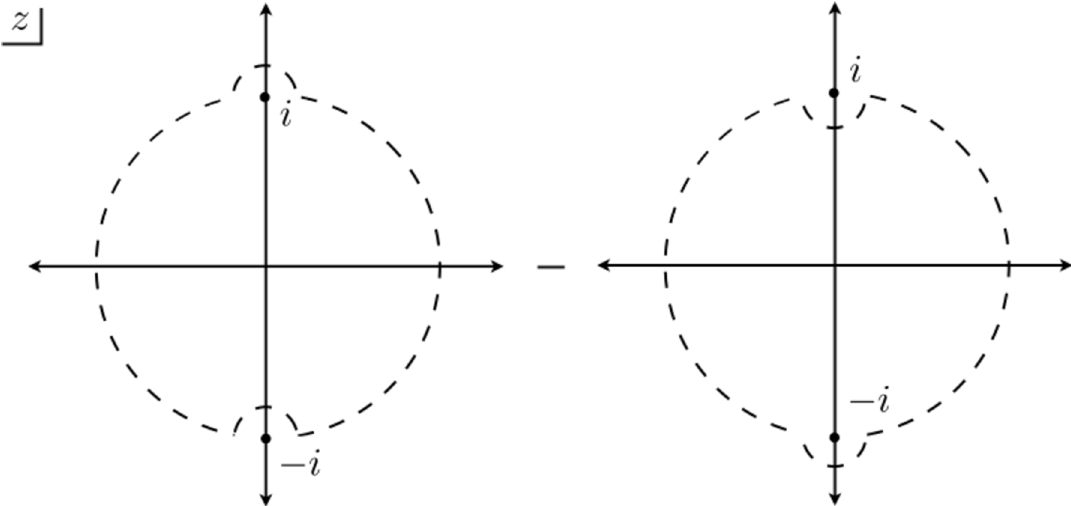
Figure 5 . One simple choice of linear functional, constructed from the difference of | z − i(cid:15) | = 1 and | z + i(cid:15) | = 1 contours. When considering a non-restricted set of generators, there is an ambiguity in the choice of projection. For instance, it is also possible to choose either of these contours separately (but not their sum) and still satisfy the required properties for the linear functional. This ambiguity is tied to the fact that the adjoint action is not diagonalizable over the Virasoro